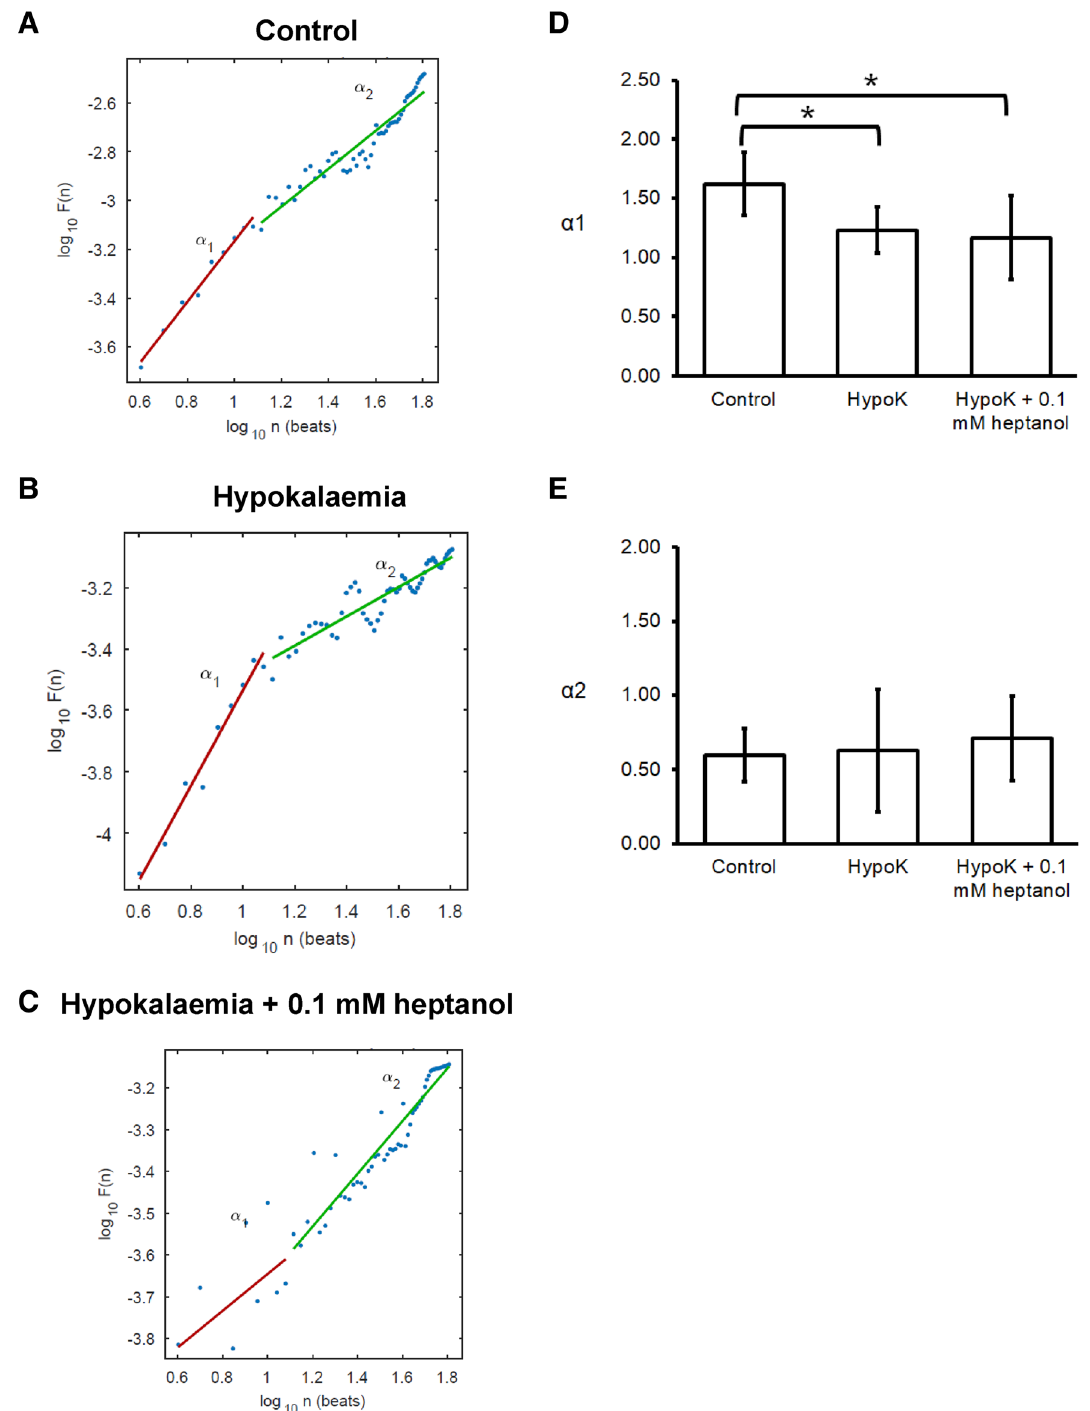
Fig. 7 Detrended fluctuation analysis plots expressing detrended fluctuations F ( n ) as a function of n in a log–log scale before ( A ) or after the application of experimental hypokalaemia ( B ) and hypokalaemia with 0.1 mM heptanol ( C ). Short-term ( D ) and long-term ( E ) fluctuation slopes ( n 7 =